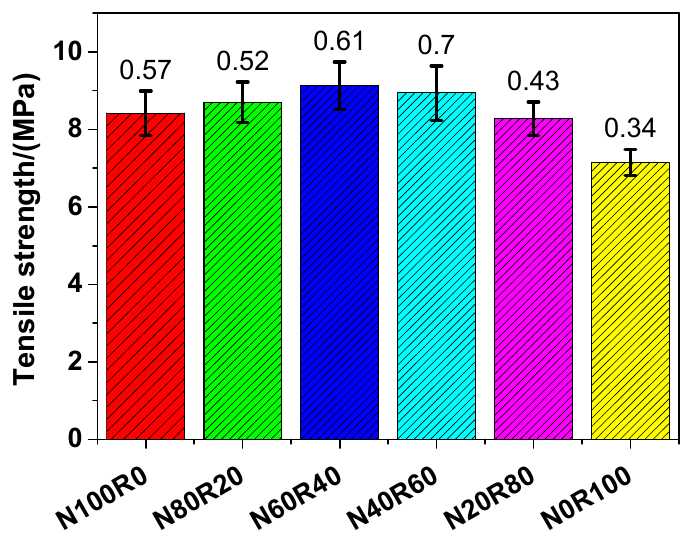
Figure 6. Tensile strength of UHPC.